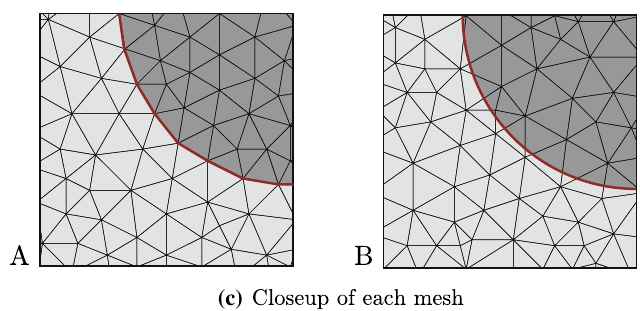
Fig. 8 Finite element meshes for 2D three-point bending problem